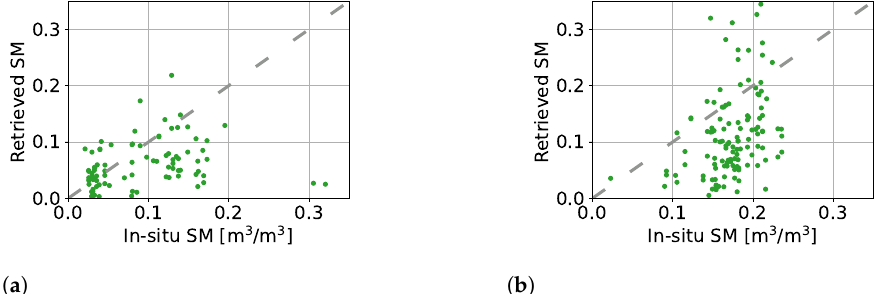
Figure 15. Soil moisture retrieval using the first scheme from DDMs close to Y8, Yanco site, compared to in situ measurements of Y8 station only. ( a ) Year 2019. ( b ) Year